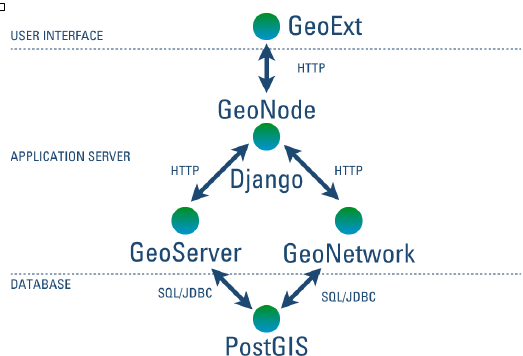
Figure 8. GeoNode Architecture